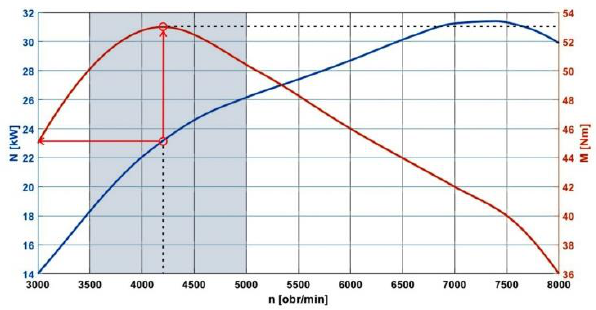
Fig. 6. Rotational characteristics of the